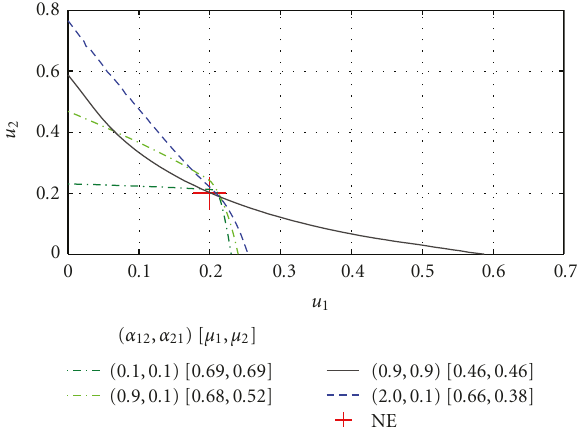
Figure 3: The Pareto boundaries for various ( α 12 , α 21 ) as shown in round brackets in the legend, ( u r 1 , u r 2 ) = (0 . 2,0 . 2) and ρ = 10 dB. The corresponding optimal prices as shown in square brackets. The NE and ( u r 1 , u r 2 ) are in the identical position.